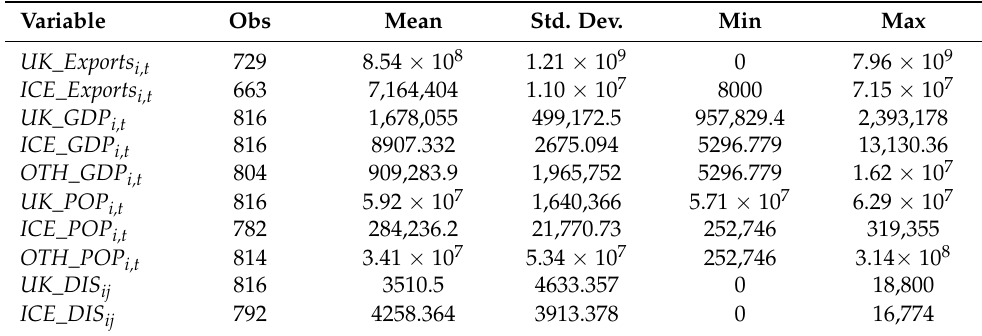
Table 2. Summary Statistics for the Sample of Data.